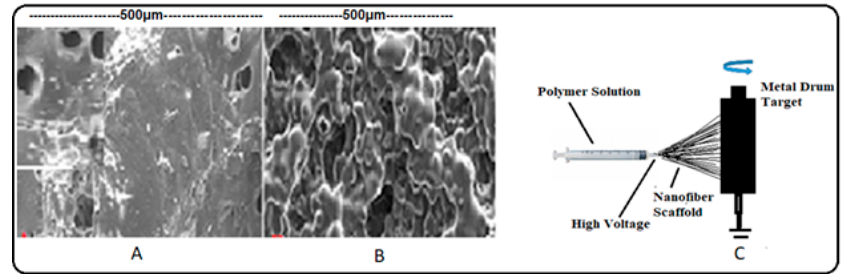
Figure 4. 3-D scaffolds. ( A ) Pores in the PLGA scaffold generated using the gas foaming method; ( B ) Figure 4. 3-D sca ff olds. ( A ) Pores in the PLGA sca ff old generated using the gas foaming method; Pores in the PLGA scaffold generated using solvent casting and particulate leaching method; ( C ) ( B ) Pores in the PLGA sca ff old generated using solvent casting and particulate leaching method;